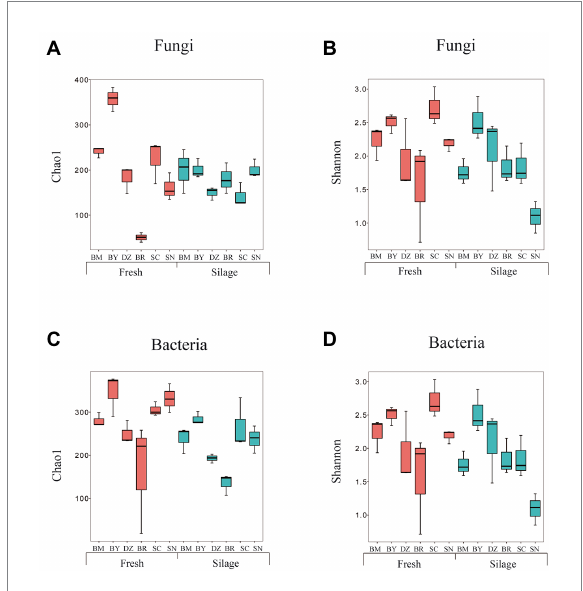
FIGURE 1 Alpha diversity of fungal (A,B) and bacterial (C,D) community diversities of fresh and ensiled oat along the elevation gradient on the Tibetan Plateau. BM, Bomi County; BY, Bayi County; DZ, Dazi County; BR, Biru County; SC, Suo County; SN, Seni County.